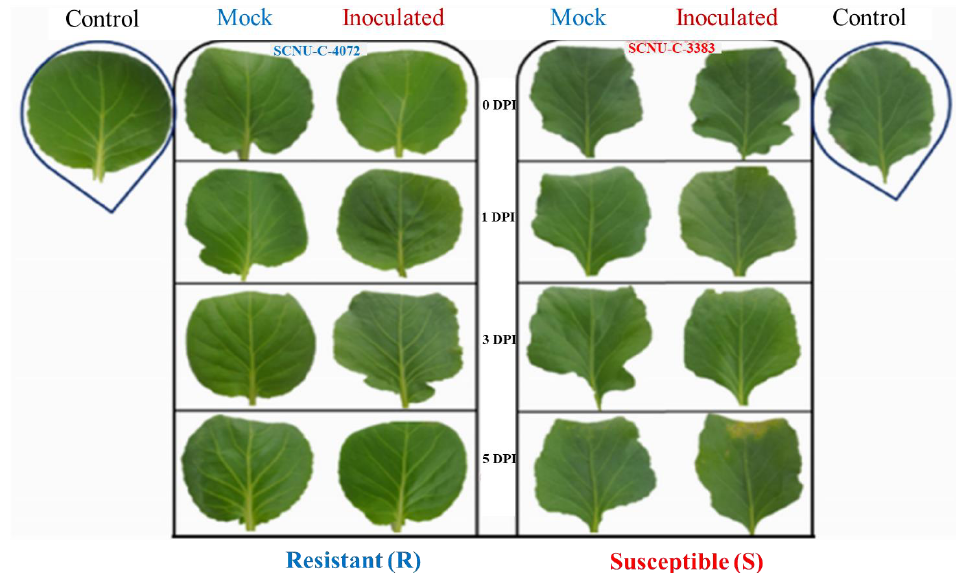
Figure 1. Black rot disease progress in resistant, R (SCNU-C-4072) and susceptible, S (SCNU-C-3383) cabbage lines. Thirty five (35) days old plants were inoculated with X . campestris pv. campestris race 4 isolate. Infected plants were observed up to 14 DAI (days after